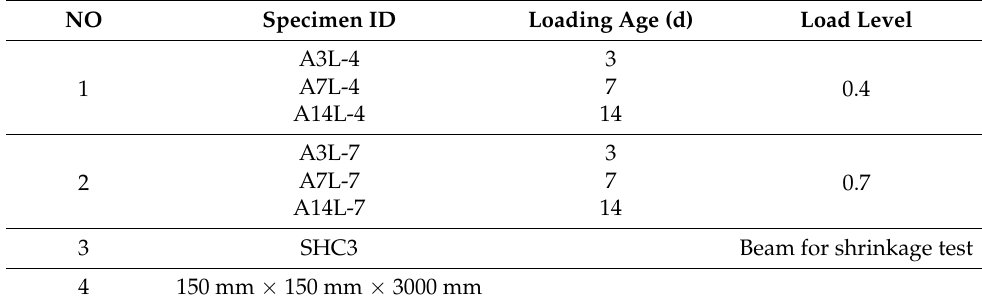
Table 2. The main loading parameters of the T-beam specimens.